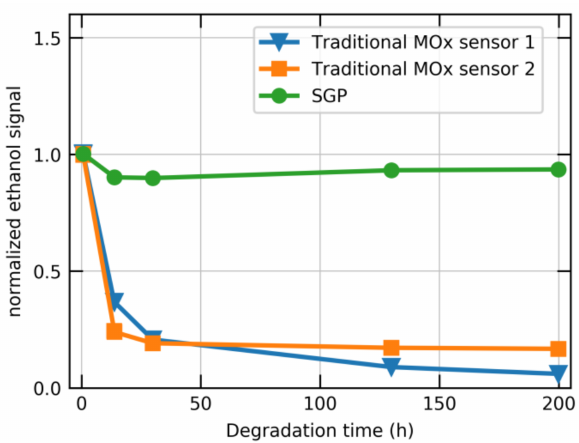
Figure 5. Long-term stability in an accelerated life-time test. The normalized ethanol concentration for different degradation time intervals is plotted for two commercially available sensors (blue and orange) and one Sensirion SGP sensor (green). The sensors have been calibrated before the accelerated lifetime test. The signals are normalized to their respective values before the